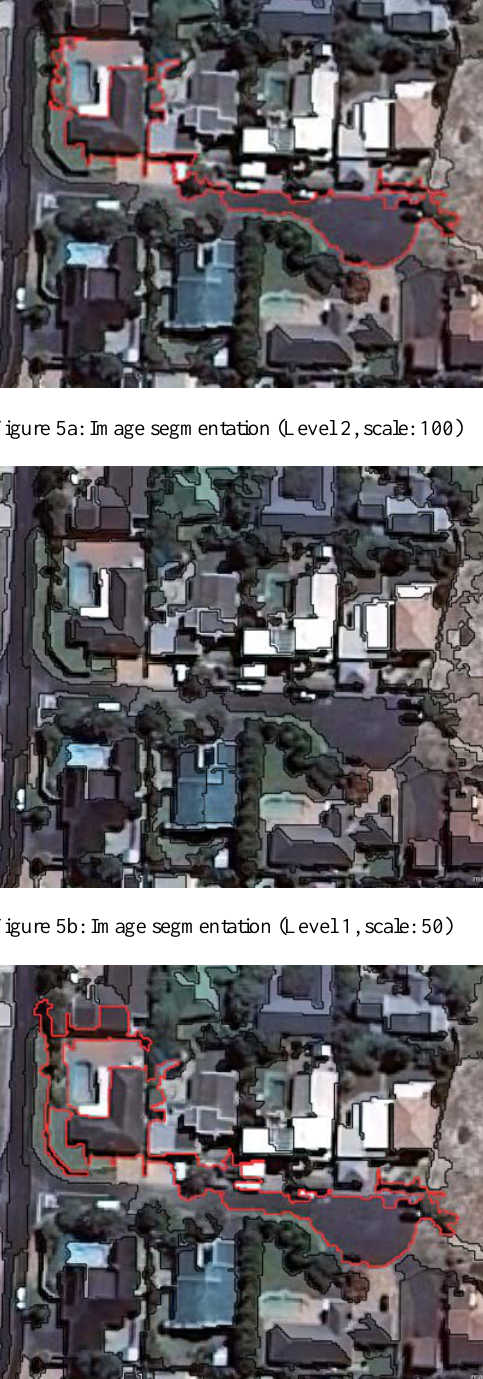
classification: mean values for red, green, blue and near infrared, brightness, maximum difference, compactness, length, length/width, HSI transformation, NDVI, GLCM mean (quick 8/11) (all dir.) and GLDV Ang. 2 nd moment mean (quick 8/11) (all dir.).